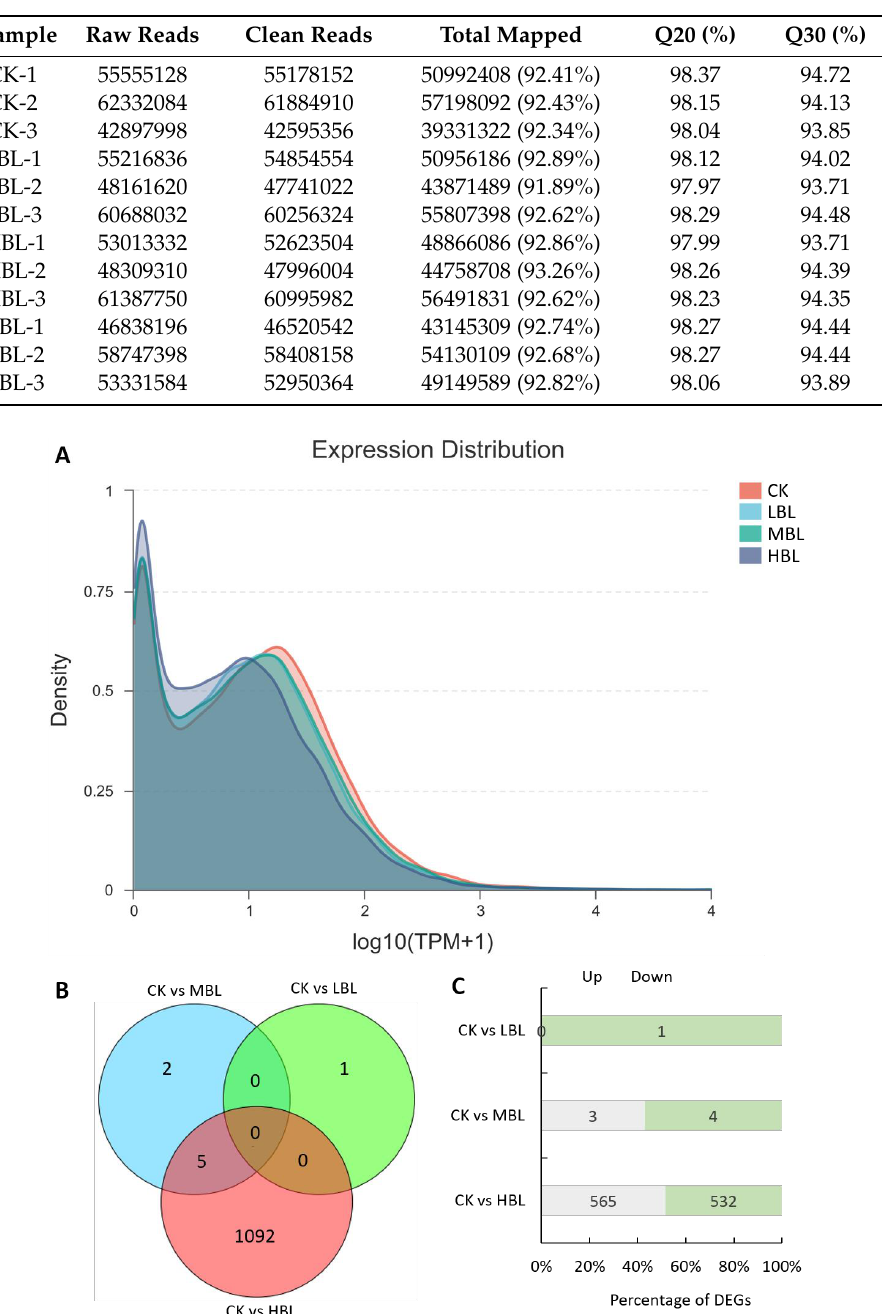
Table 1. Quality of the transcriptome data of each sample.